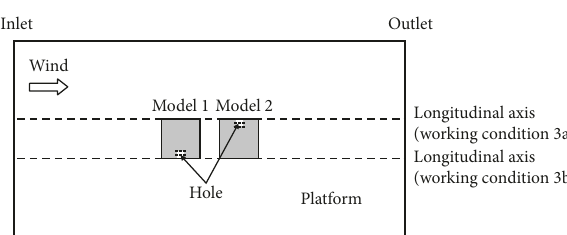
Figure 11: Three working conditions of snow depth coefficient of the longitudinal